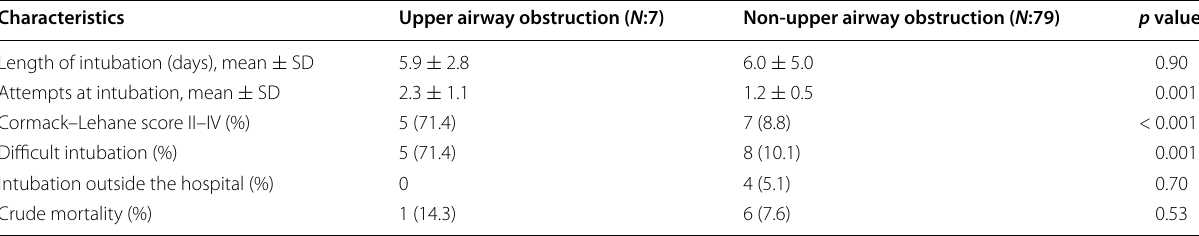
Table 3 Characteristics of patients with upper airway obstruction Characteristics